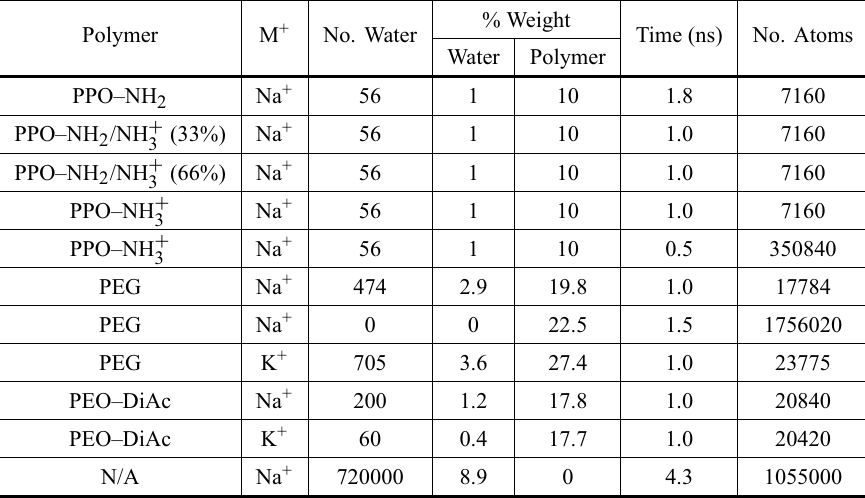
Simulation cell composition of clay-polymer molecular models. For the mixed PPO-NH 2 /NH + 3 systems the percentage NH + 3 content is